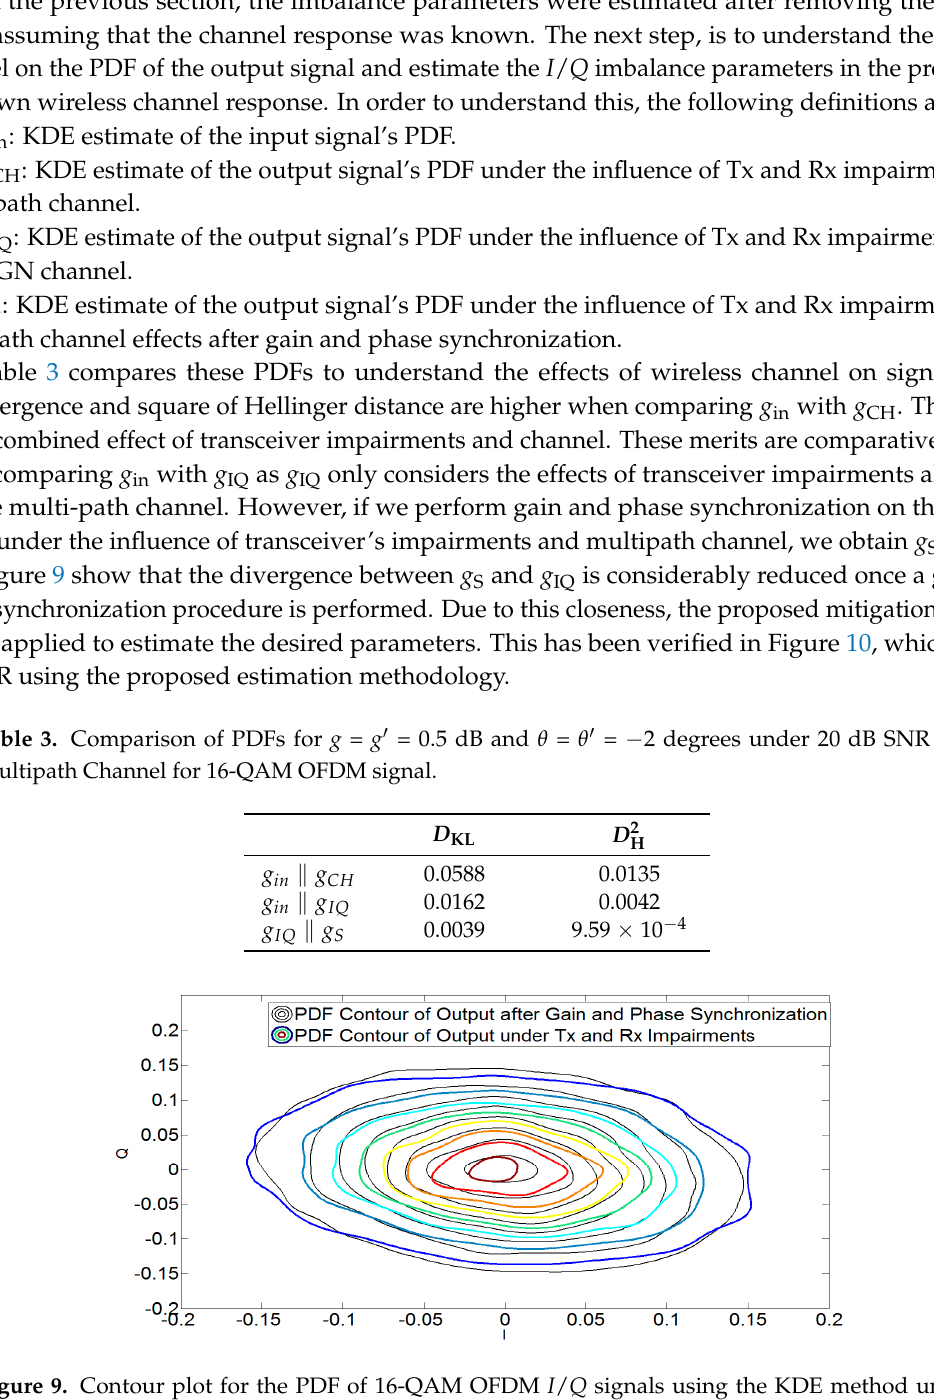
Figure 9. Contour plot for the PDF of 16-QAM OFDM I / Q signals using the KDE method under multipath channel and 20 dB SNR. The colored contours show the variations in PDF due to Tx and Rx I / Q imbalance only under Additive White Gaussian Noise (AWGN). The black contours show the PDF of the output signal under the influence of I / Q imbalance and channel after gain and phase synchronization.